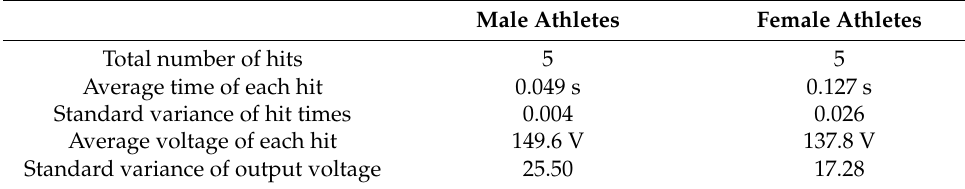
Figure 5. Actual test of FL ‐ TENG. ( a ) Turning kick test for male athletes. ( b ) Turning kick test for female athletes. ( c ) Male athlete 360° turning kick test. ( d ) Female athlete 360° turning kick test. ( e ) Back kick, side kick, and turning kick proficiency test for female athletes. Table 1. Athletes’ medium ‐ strength turning kick data.